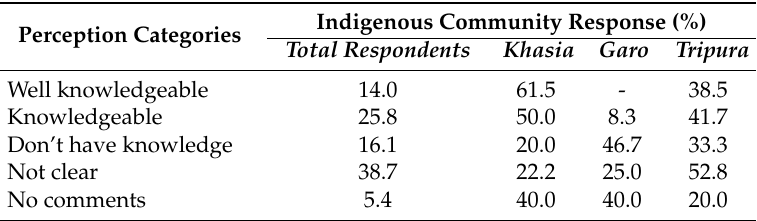
Table 2. Indigenous community perception regarding climate